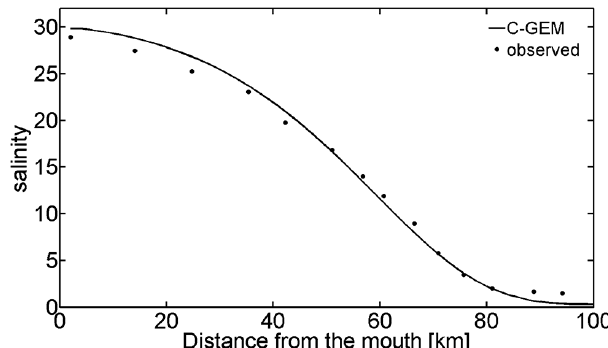
Figure 6. Comparison between observed (1981–1990) (dots) and simulated neap (dashed line) and spring (solid line) tidal amplitudes modeled using a constant freshwater discharge Q = 100m 3 s − 1 .